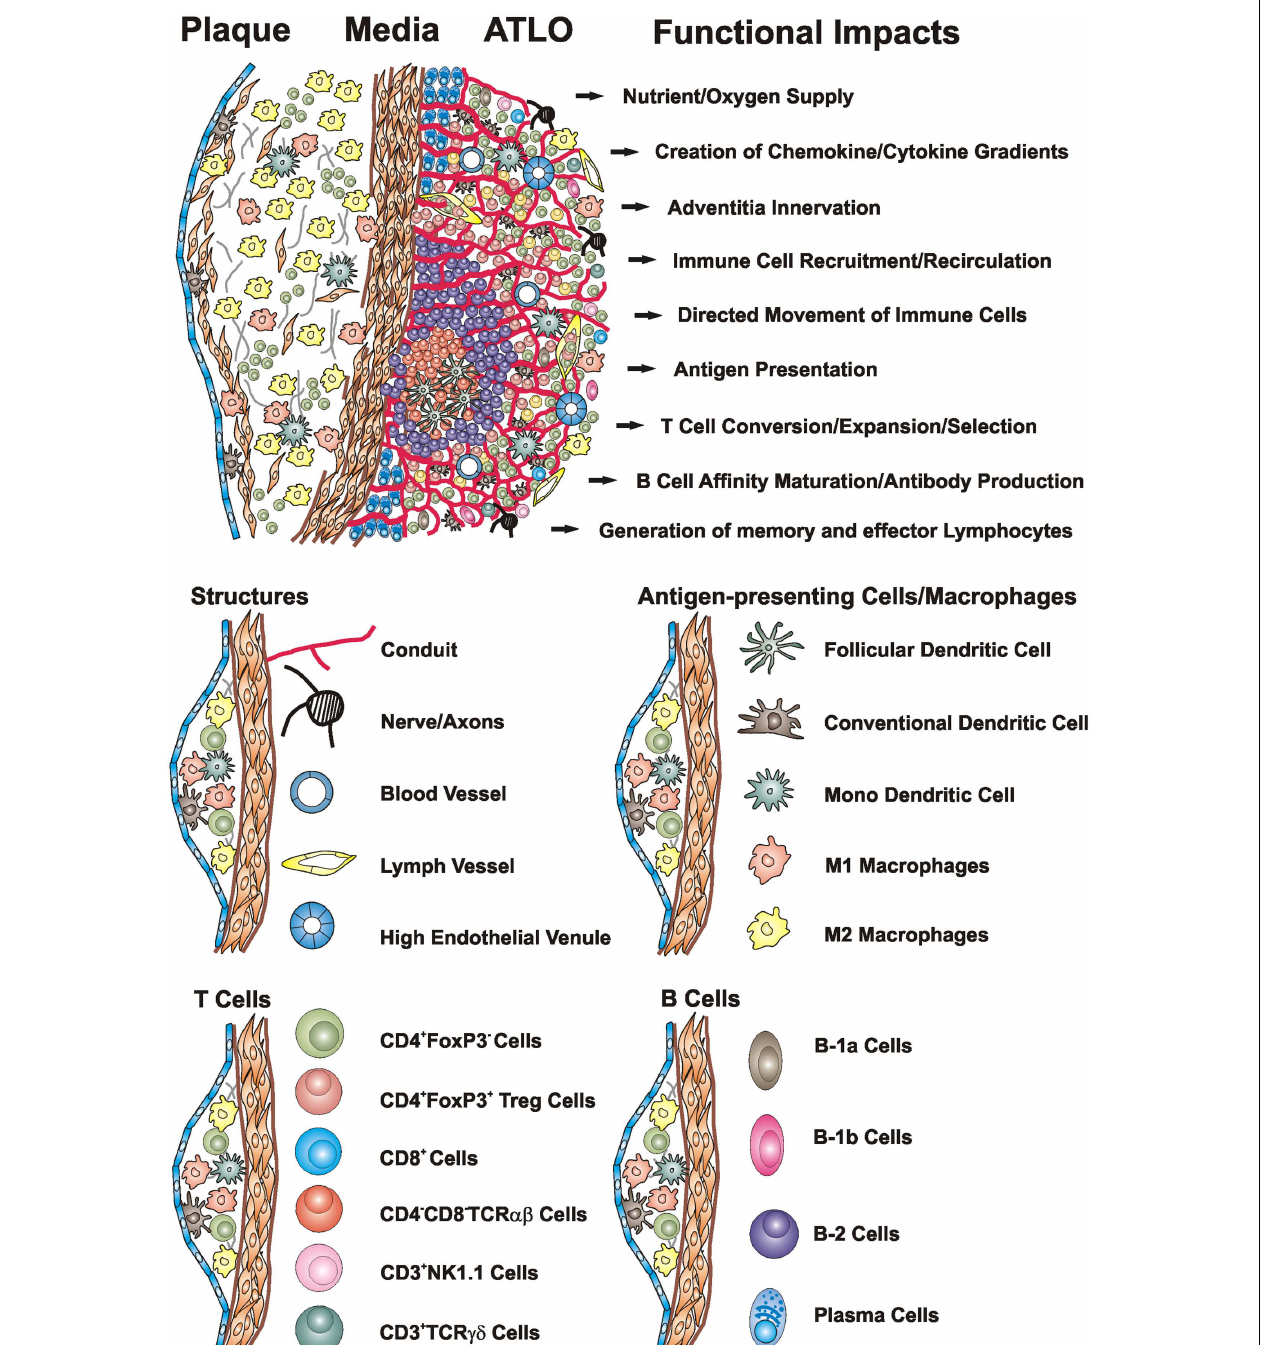
molecules. In unpublished analyses, we observed a dense network of nerve axons within ATLOs but their impact remains unclear. Extensive newly formed blood vessels provide nutrient and oxygen supply. ATLOs strongly supportT cell recruitment and recirculation whereas aberrant lymphangiogenesis may promote recruitments of DCs and other immune cells into the inflamed adventitia. ATLOs harbor several APCs including FDCs, cDCs, mDCs, and B cells. Several B-2 cells at different stages of differentiation and plasma cells are present in activated B cell follicles and the ATLO periphery, respectively.We also identified increased populations of innate B-1a and B-1b cells by FACS. Modified from Gräbner et al.